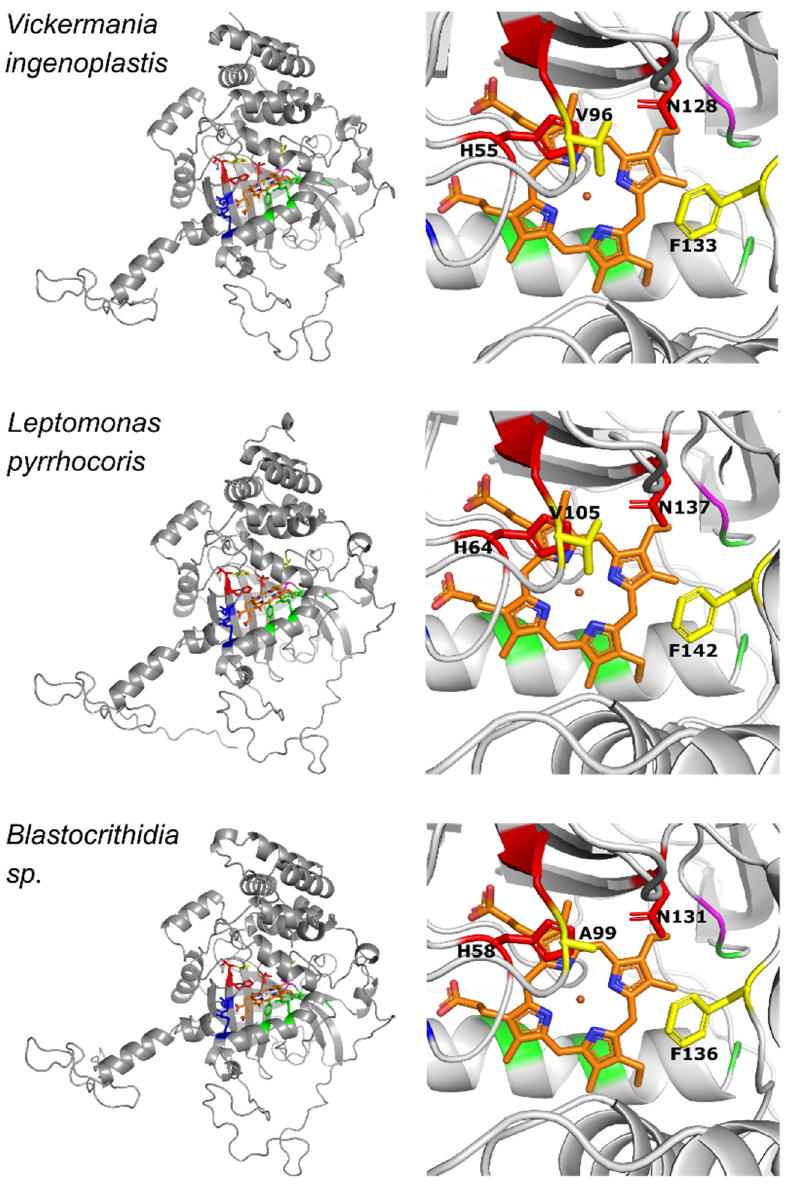
Figure 5. Predicted three-dimensional structures of the monomers of trypanosomatid catalases. Left column: overall structure; right column: heme pocket and the innermost part of the channel. Superimposed heme group is in orange with N and O atoms colored in blue and pink, respectively. Green and red indicate proximal and distal heme sides, respectively. Blue, heme propionate side chains; magenta, heme vinyl side chains; residues shown in red and yellow are His and Asn of the distal side and Ala/Val and Phe of the main channel, respectively. The PAE (predicted average error) plots for the modeled structures are presented in Supplementary Figure